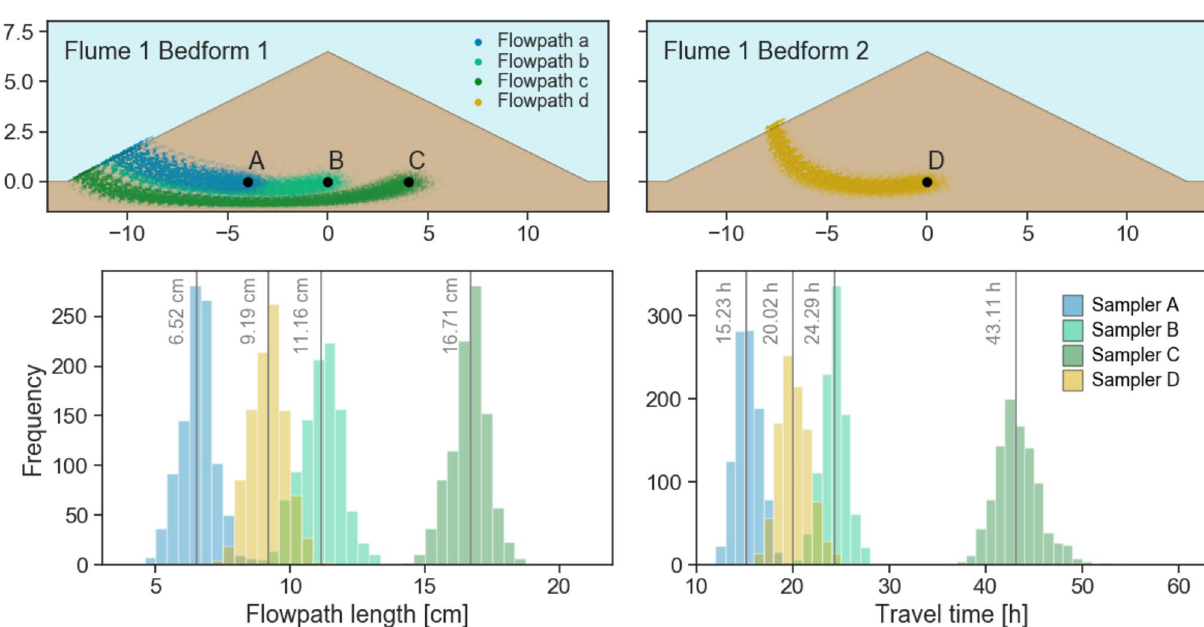
Figure 5. Top: Trajectories of particles along Flowpaths a, b, c and d in Bedforms 1 and 2 calculated by the hydrodynamic model. Bottom: Distribution and median values of flowpath lengths and travel times from SW to PW Samplers A, B, C and D. Figure adapted from Betterle et al. 38